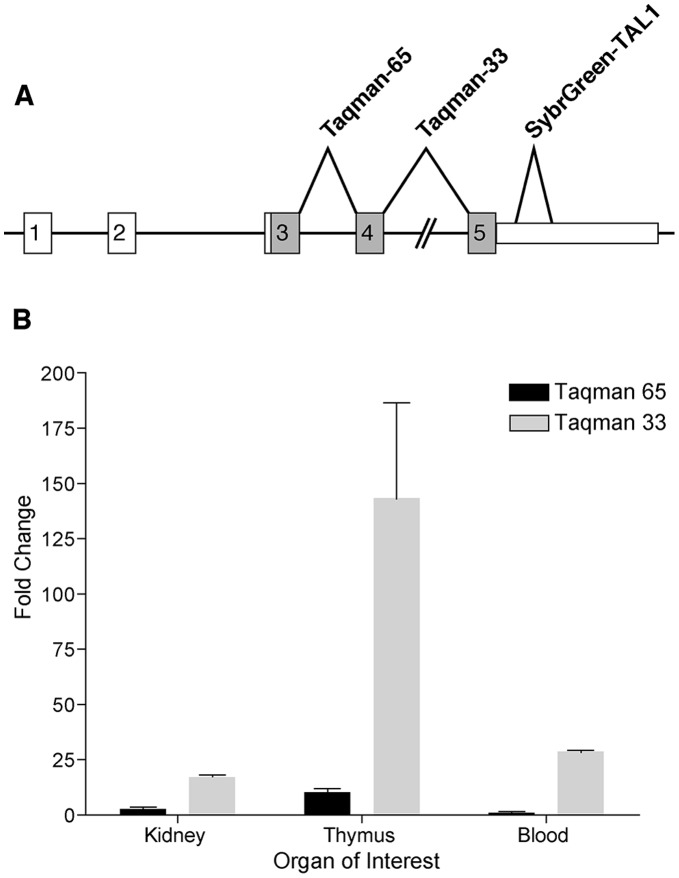
Real-time qPCR analysis of Tal1 expression using Taqman probes.The Taqman-65 and -33 probes span exons 3 and 4, and exons 4 and 5, respectively (A). While the increased expression of Tal1 in Hpt/+ mice versus +/+ controls is significant with both probe sets in all organs tested, the more 3′ Taqman-33 shows greater up-regulation than the Taqman-65 probe located more 5′(B).